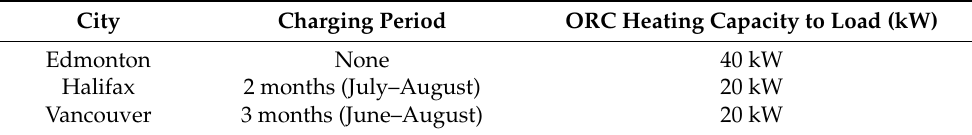
Table 5. Modifications to system model for each selected city.